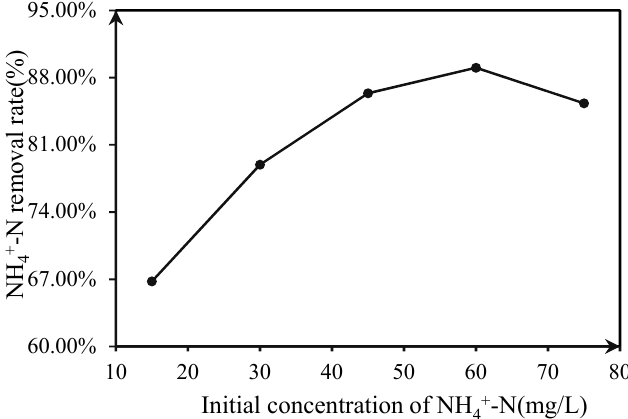
Figure 6. The effect of the initial concentration.